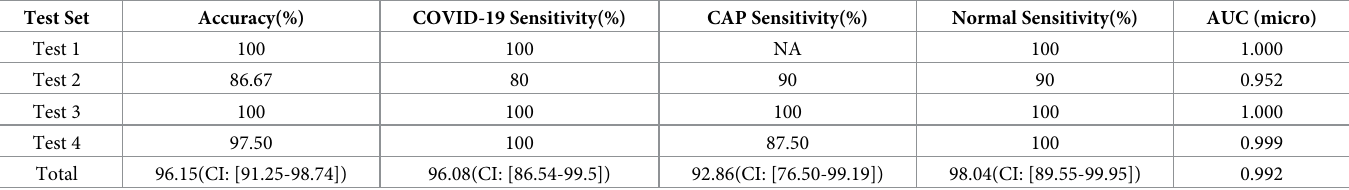
Table 5. Result obtained by the proposed framework for different test